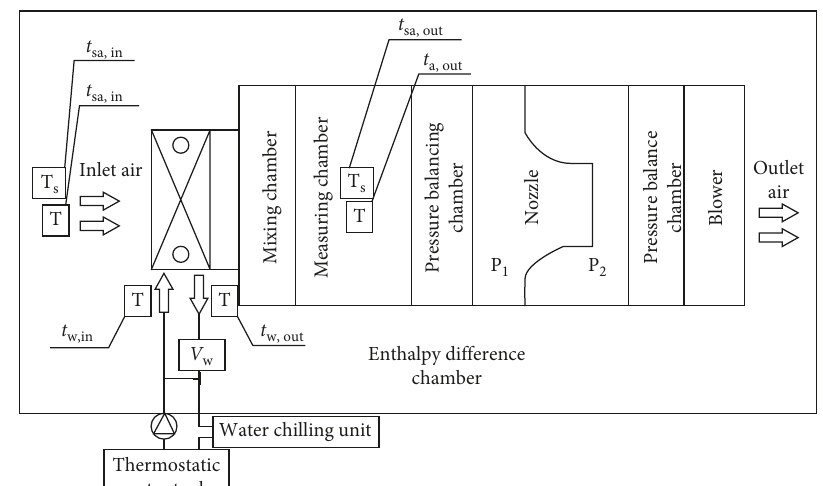
Figure 2: Model calculation logic diagram.